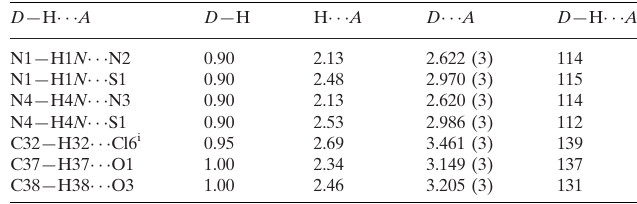
Hydrogen-bond geometry (A˚ , (cid:3)